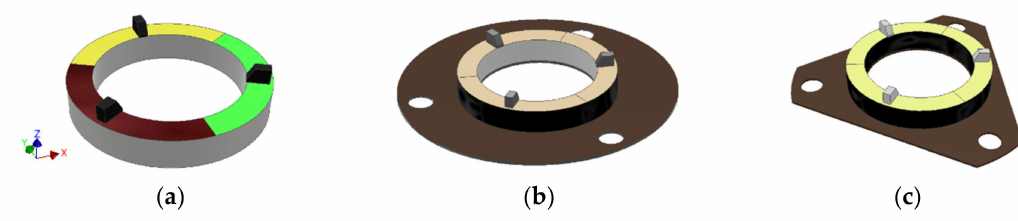
Figure 3. Numerical models which were used for simulations: ( a ) piezoelectric actuator, when flange is bonded using soft rubber spacers; ( b ) piezoelectric unimorph with ring-shaped flange; ( c ) piezoelectric unimorph with triangle-shaped flange.